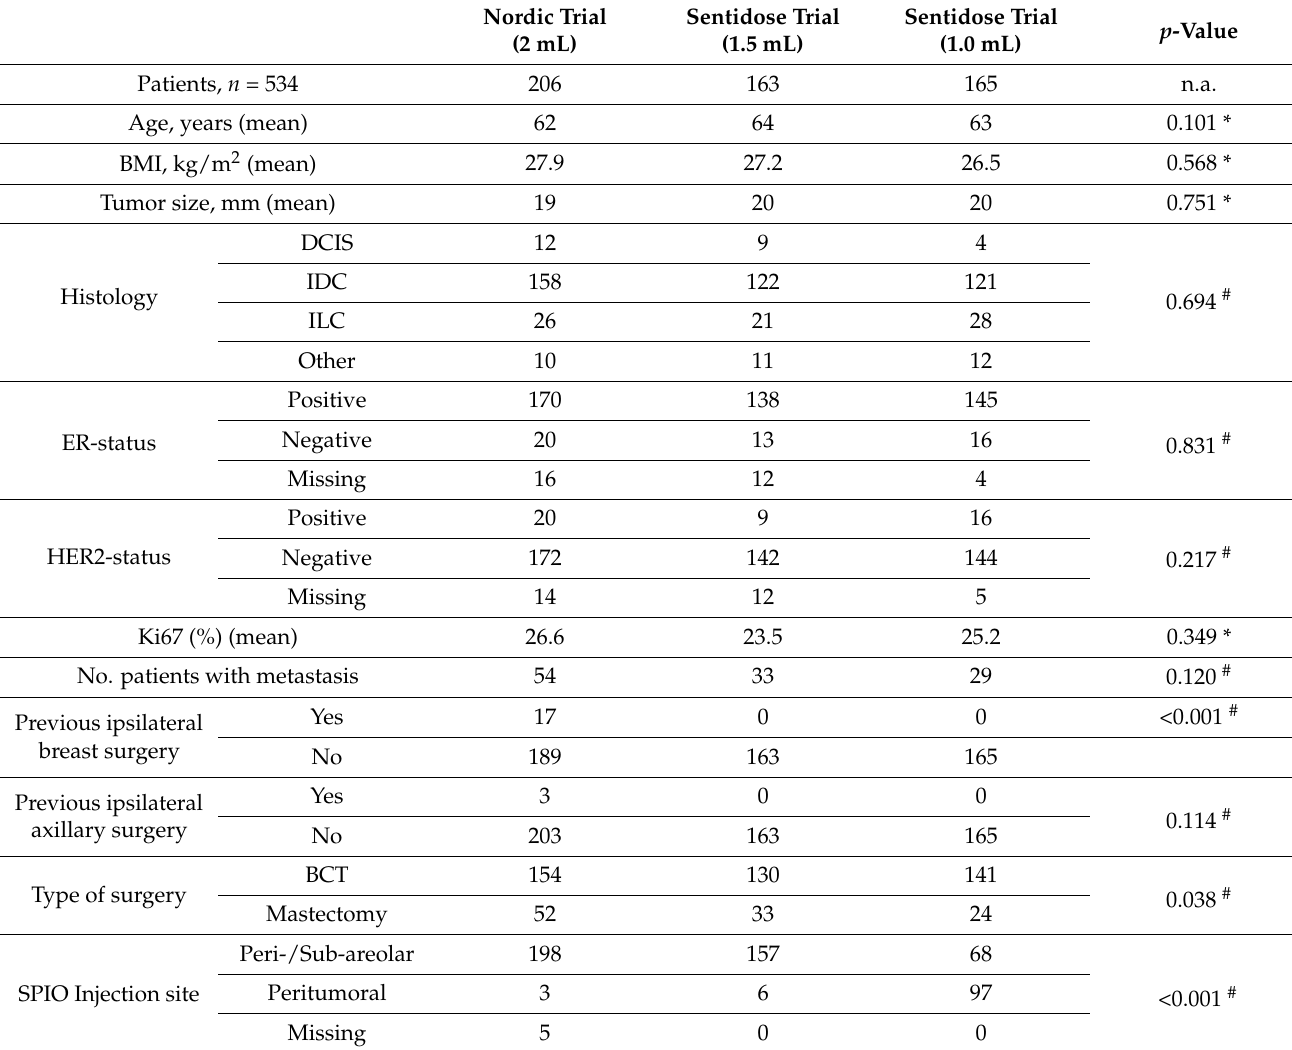
Table 1. Patient and tumor characteristics. Nordic Trial (2